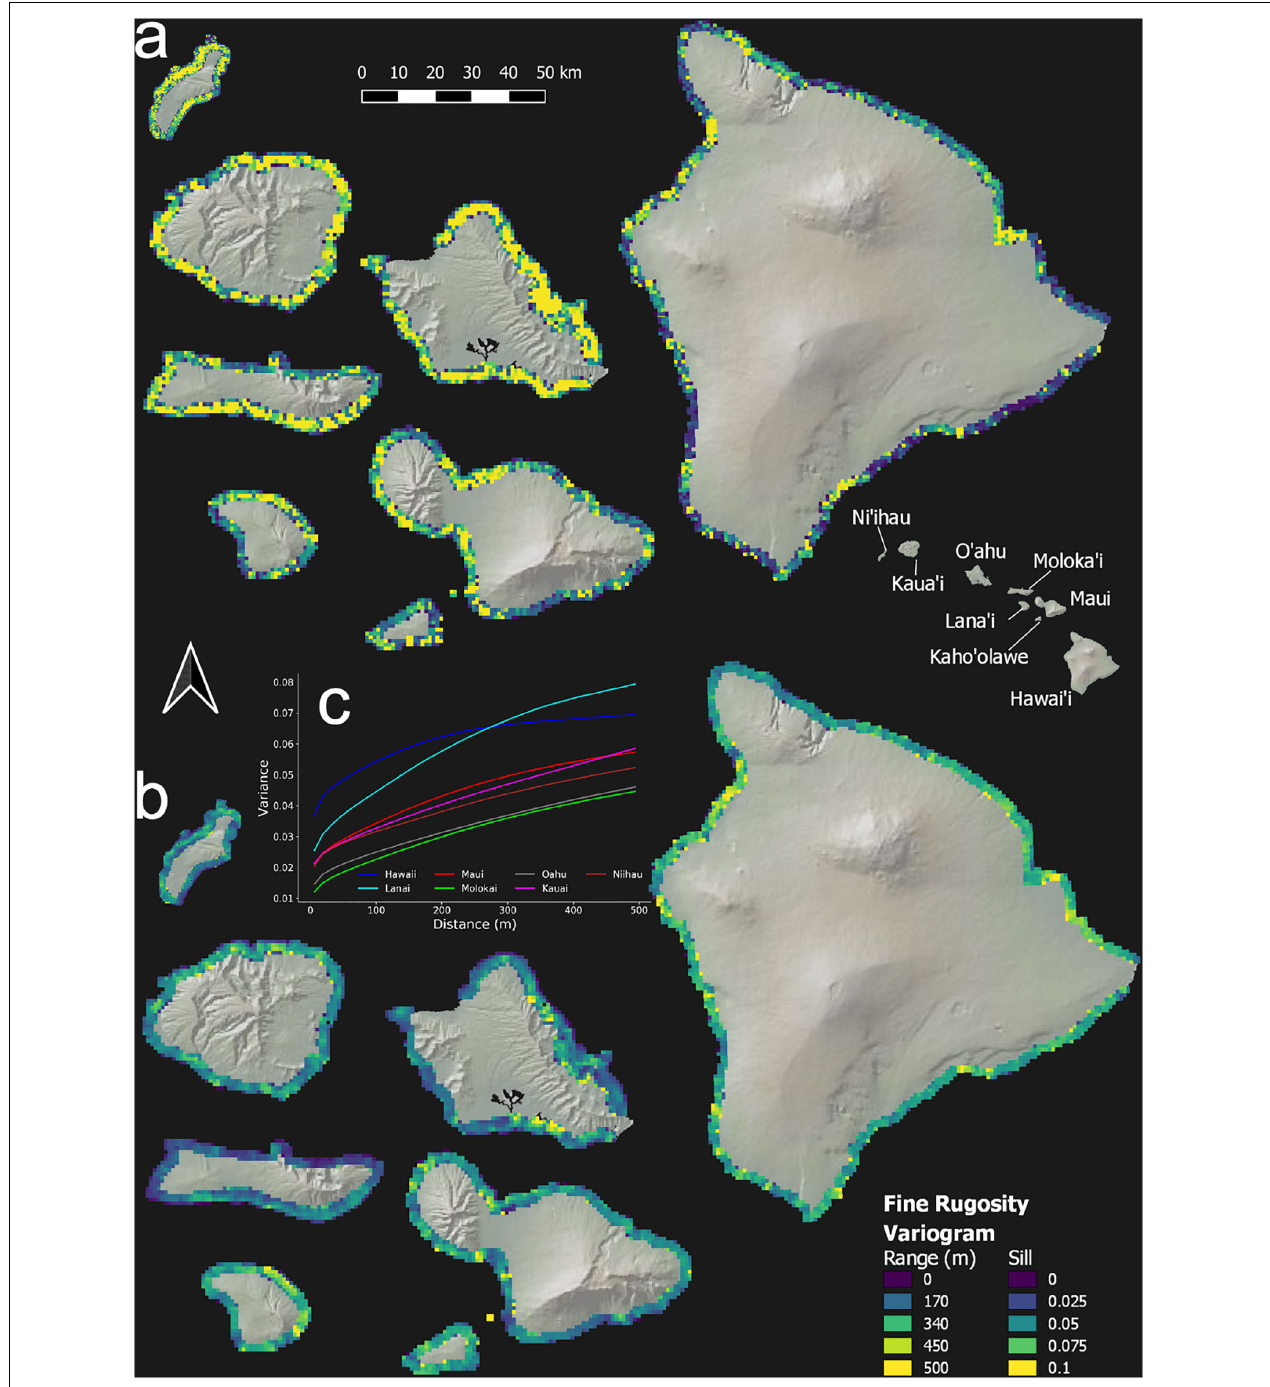
FIGURE 5 | Geospatial variation in fine-scale rugosity for the eight main Hawaiian Islands. Semi-variogram (a) range and (b) sill are shown at the top and bottom, respectively. (c) Island-scale semi-variograms in the inset graph. Coarse-scale rugosity is provided in Appendix Figure A3 .